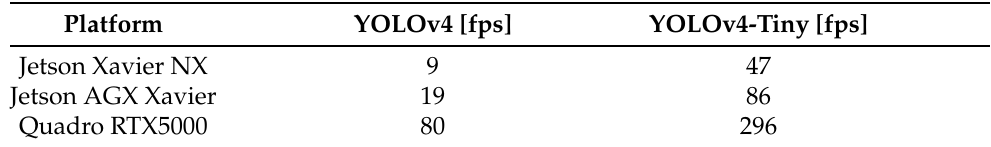
Table 5. Mean performance on different GPU platforms for the test